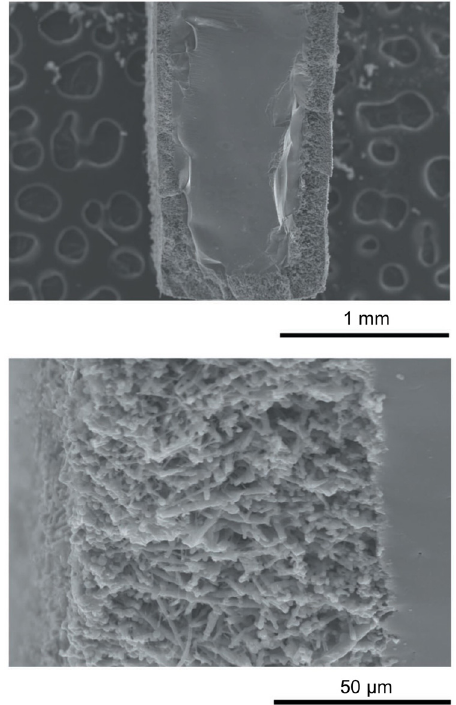
Figure 11: Cross - sectional SEM images of the reduction product obtained by potentiostatic electrolysis of a SiO 2 plate at 1.0V vs Ca 2 + / Ca in molten CaCl 2 at 1,123K [ 201 ] . Permission from Springer Nature.